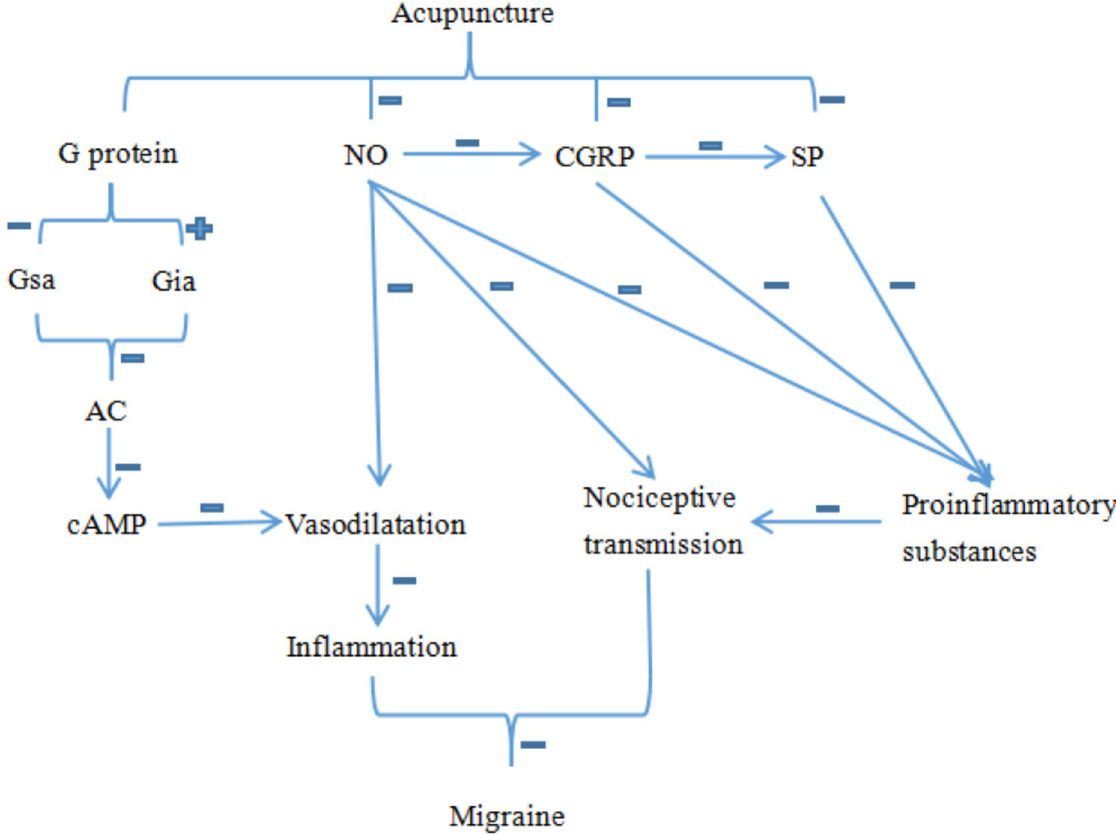
Fig 6. Mechanism of acupuncture in the treatment of